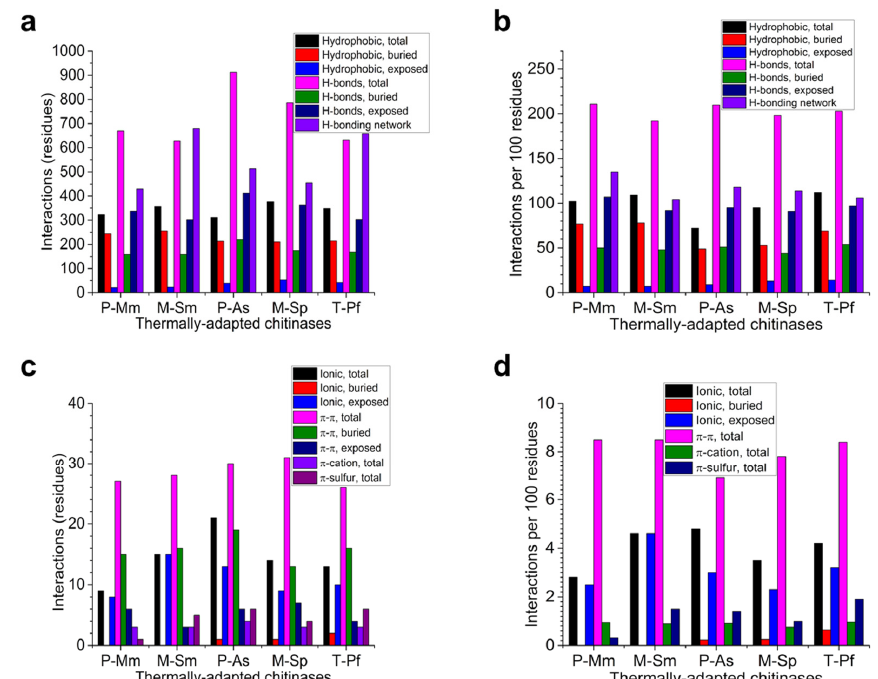
Figure 3. Various interactions in thermally-adapted chitinases. ( a ) Total hydrophobic interactions and hydrogen bonds (H-bonds). ( b ) Normalized hydrophobic interactions and hydrogen bonds per 100 residues. ( c ) Total ionic and pi interactions. ( d ) Normalized ionic and pi interactions per 100 residues. Hydrophobic interactions (within 5 Å), H-bonds (dA:O, N, 3.5; S, 4.0 Å), ionic/salt bridges (within 4 Å), π - π (4.5–7.0 Å) and π -sulfur interactions (within 5.3 Å) were found using PIC; π -cation interactions (within 6 Å) were found using realistic electrostatics (CaPTURE) and the optimal H-bonding network was found using WHATIF. Higher values of interactions are associated with higher stability. P, psychrophilic; M, mesophilic; T, thermophilic. Mm, M. marina ; Sm, S. marcescens; As, Arthrobacter sp.; Sp, S. proteamaculans ; Pf, P. furiosus.